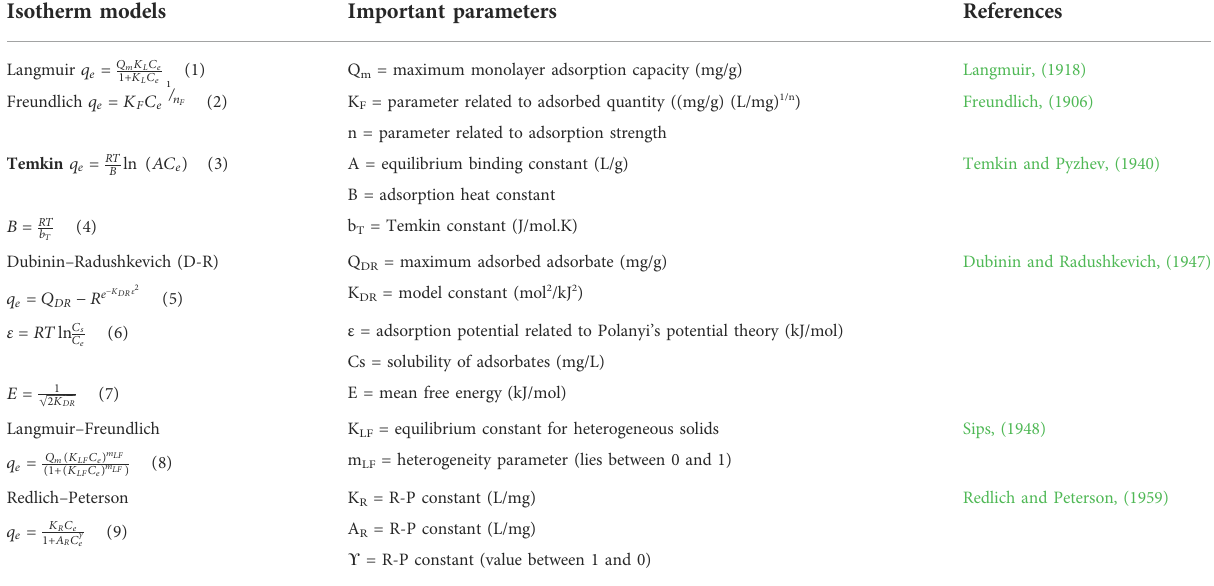
TABLE 7 Summary of common isotherm models used in adsorption systems that involved date palm residues. Isotherm